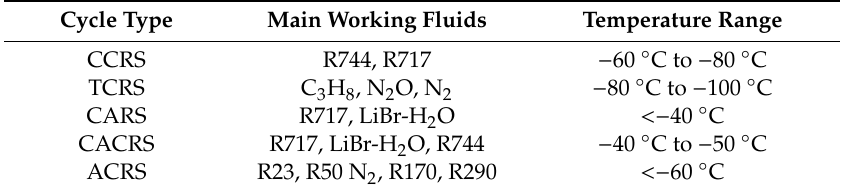
Table 1. The associated fluids and temperature ranges for the various CRS in the investigations reviewed in this work.